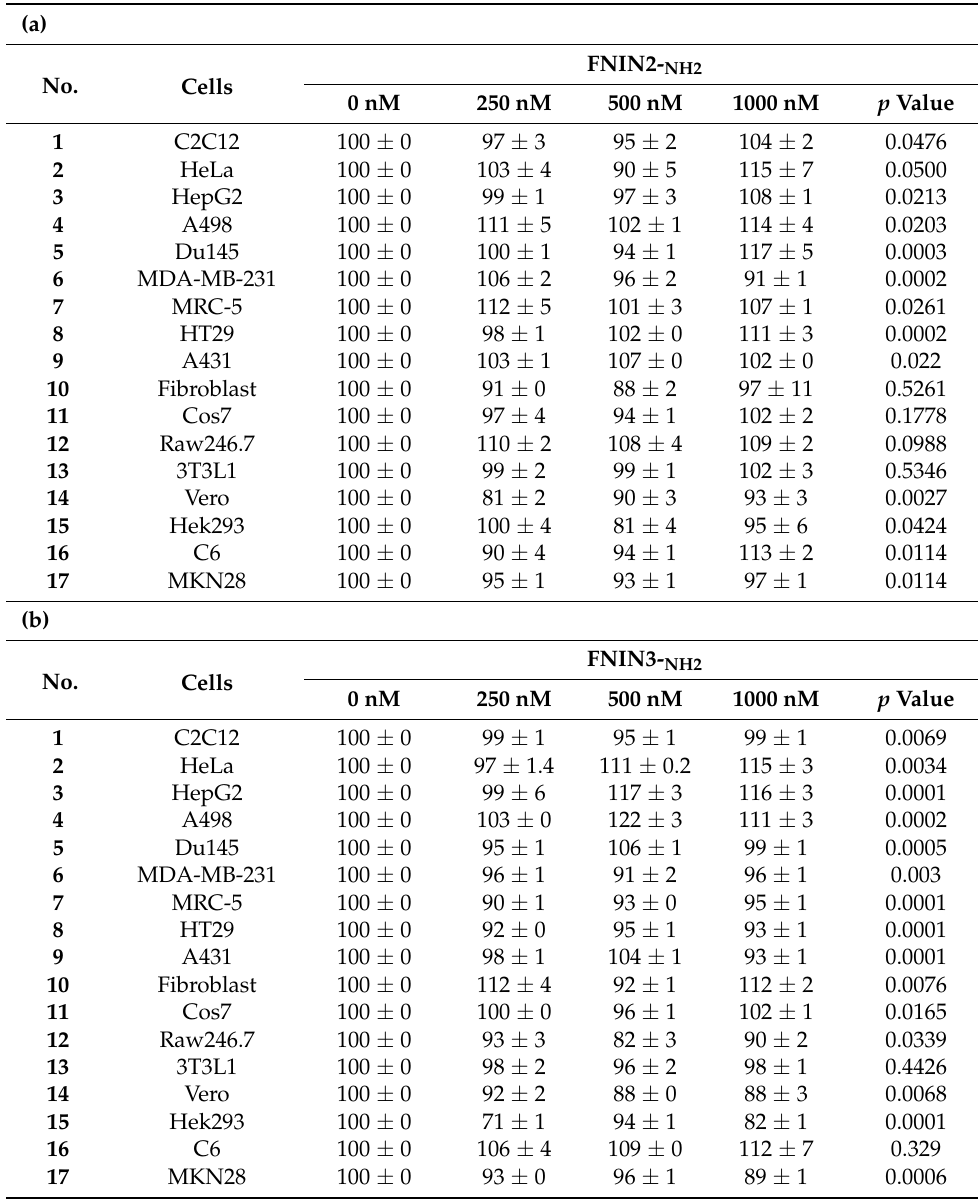
Table 2. Impacts of FNIN2 and FNIN3 on cell proliferation. a. FNIN2- NH2 effects. b. FNIN3- NH2 effects. 0 nM treated cells were used as controls. Means ± SD ( n >